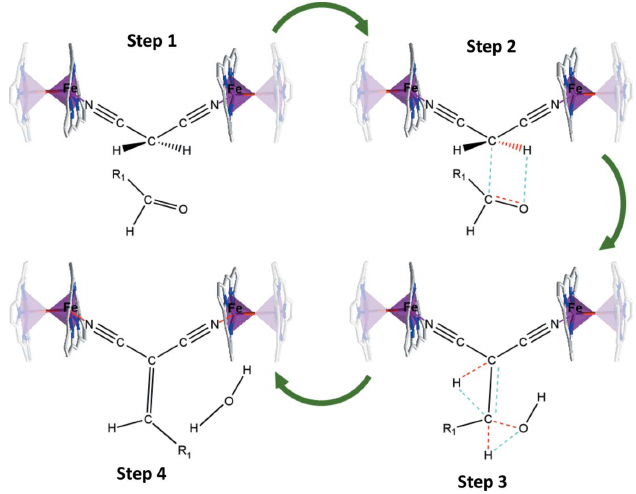
Figure 7 Proposed mechanism for the benzyl alcohol Knoevenagel condensation over catalyst 2 . Colour code: Fe purple, C grey, N blue and O red. Bonds to be removed (red dashed lines) and created (turquoise dashed lines) are